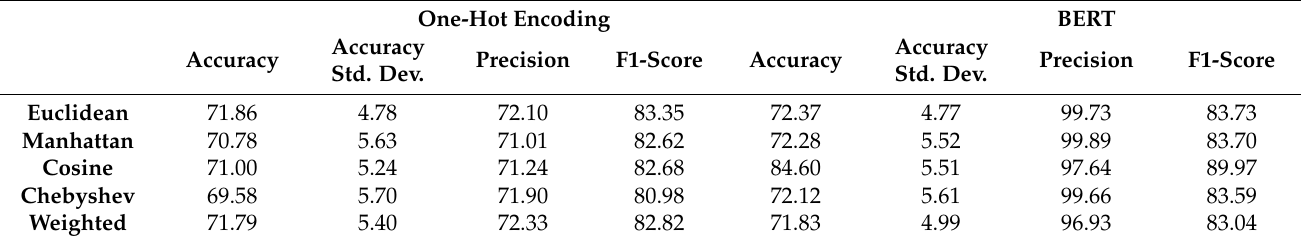
Table 3. Evaluation of the PSN distance measures with one-hot encoding and BERT.